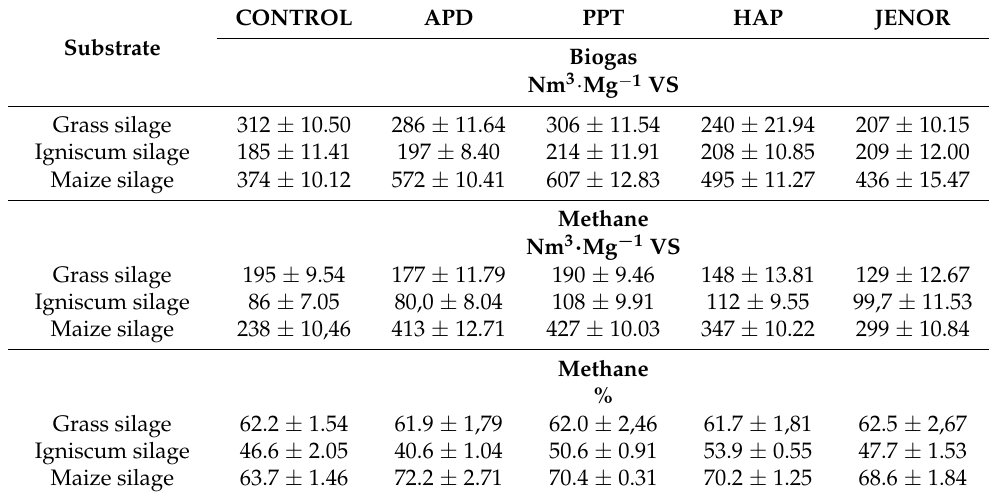
Table 3. Variations in average biogas and methane production by substrate and enzyme